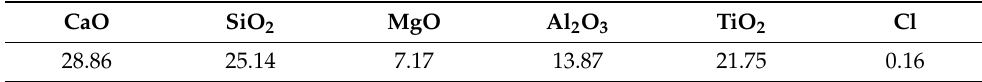
Table 1. Chemical composition of site slag in steel works (%).